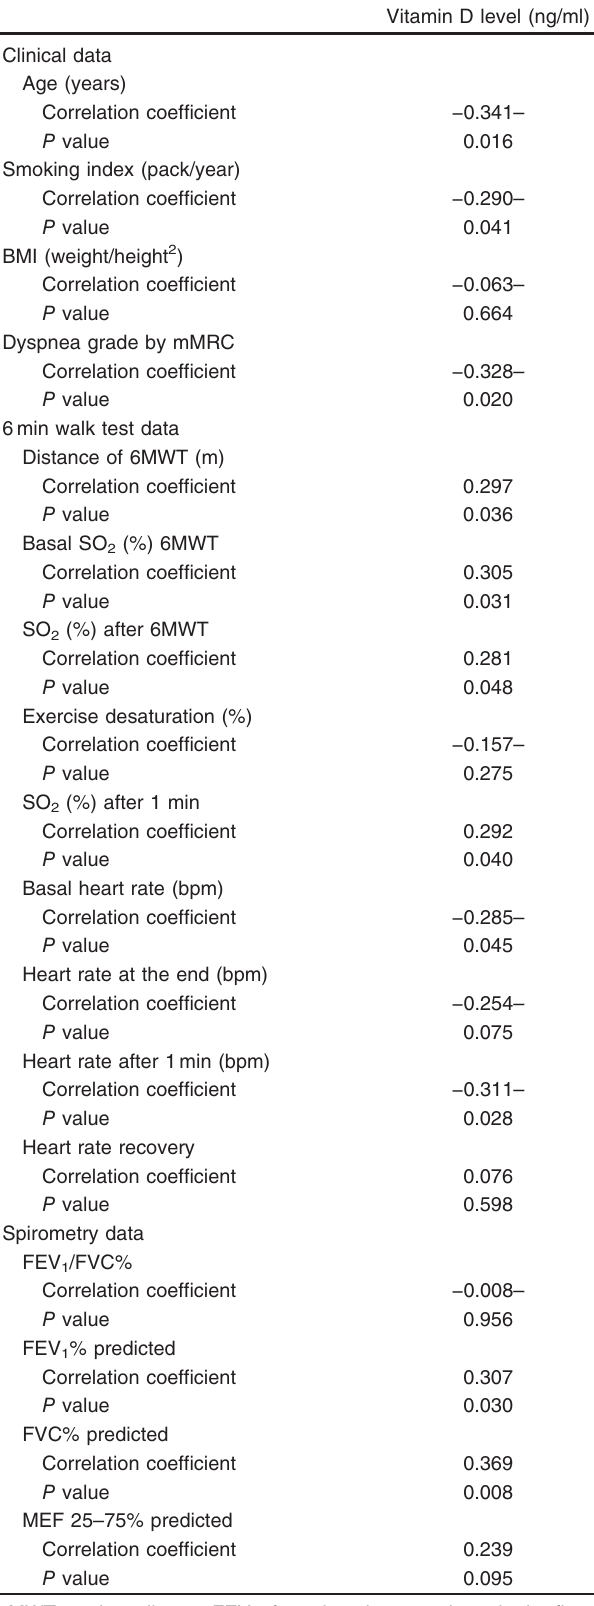
Table 4 Correlation between serum level of 25(OH) vitamin D and clinical and functional parameters of the chronic obstructive pulmonary disease